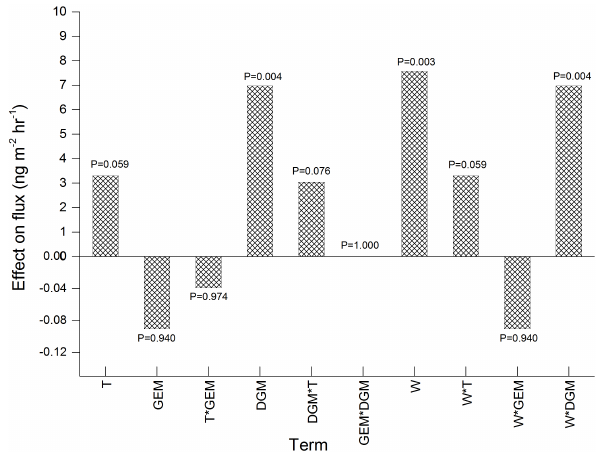
Figure 5. Sensitivity analysis based on the 2 4 factorial design shown in Table 2 (water bodies). T denotes air temperature at wa- ter surface, GEM denotes air Hg concentration, DGM denotes dis- solved gaseous Hg concentration in surface water, W denotes wind speed, and “ ∗ ” denotes the interaction effects.